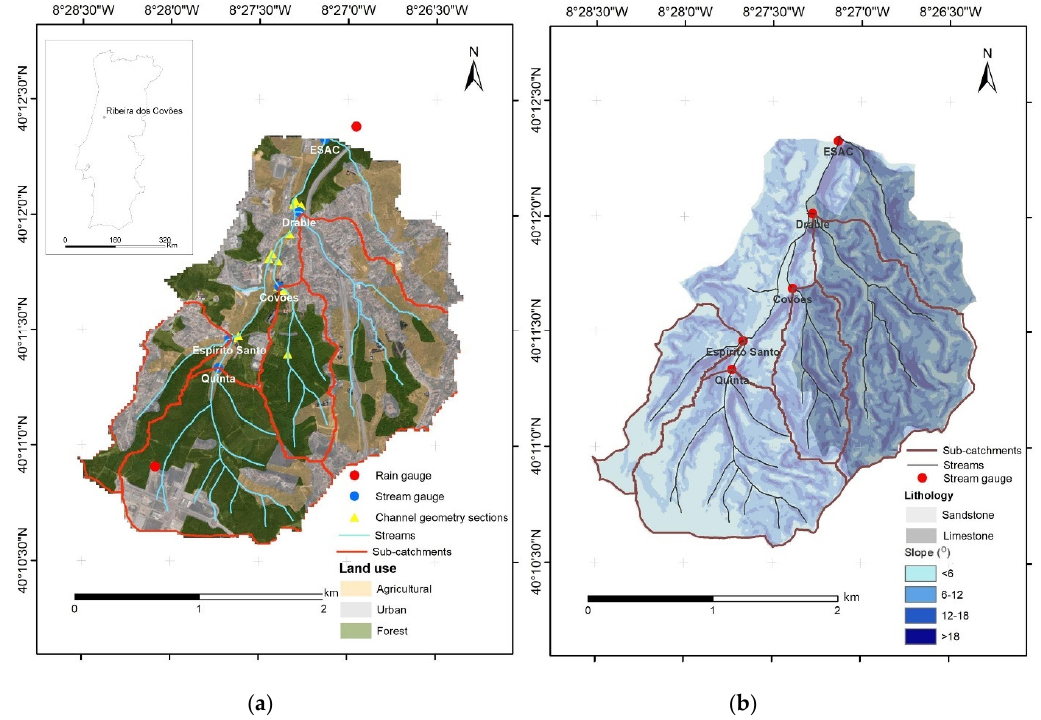
Figure 1. Location of the Ribeira dos Covões catchment in Portugal, its land use and stream network, including the hydrological monitoring network providing rainfall and streamflow data within the sub-catchment (Espírito Santo, Quinta, Covões and Drable), and of the channel cross-section profiles described during the field survey ( a ). ( b ) shows the slope and lithology within the catchment. The catchment overlies Cretaceous and Tertiary sandstone conglomerates and mudstones in the west (56%), Jurassic dolomitic and marl-limestone units in the east (41%), and some Plio-quaternary sandy-conglomerates and alluvial deposits (3%) in the main valley. The sandstone area comprises deep (>3 m; Figure 1b) Fluvisols and Podsols, whereas the limestone contains shallow (<0.4 m) Leptic Cambisols [29].